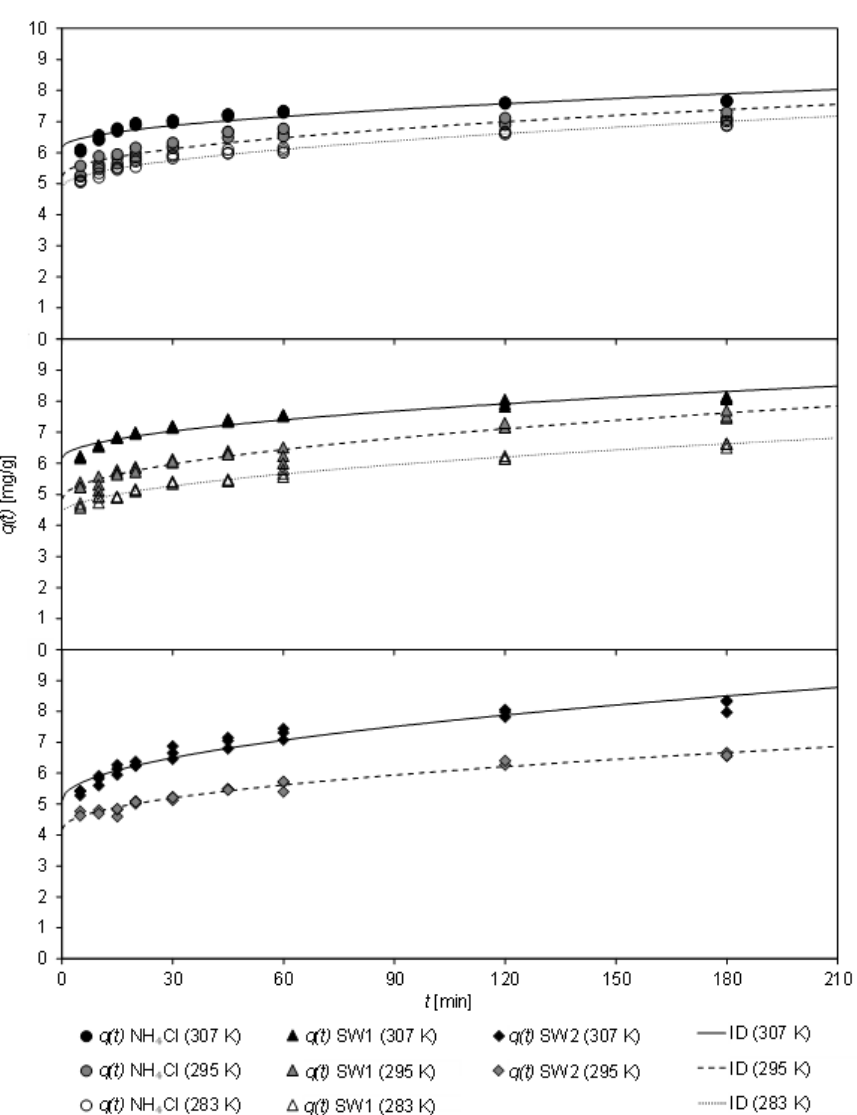
Figure 4. Loading q ( t ) of CCP 20 as a function of contact time t at different temperatures (283–307 K) Figure 4. Loading q(t) of CCP 20 as a function of contact time t at different temperatures (283–307 and fit to the ID model (specific sorbent ratio: 0.1 g CLI /mg NH4 − N ; NH4Cl solution: c 0 = 1000 mg/L K) and fit to the ID model (specific sorbent ratio: 0.1 g CLI /mg NH4 − N ; NH 4 Cl solution: c 0 = 1000 mg/L NH 4 -N; initial pH 5.3; final pH 6.3–7.0; SW1: c 0 = 967 mg/L NH 4 -N; initial pH 7.6; final pH 7.4–8.3; NH4-N; initial pH 5.3; final pH 6.3–7.0; SW1: c 0 = 967 mg/L NH4-N; initial pH 7.6; final pH 7.4–8.3; SW2: c 0 = 913 mg/L NH 4 -N; initial pH 7.6; final pH 6.5–8.2). SW2: c 0 = 913 mg/L NH4-N; initial pH 7.6; final pH